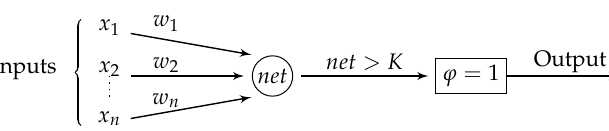
Figure 1. Neuron